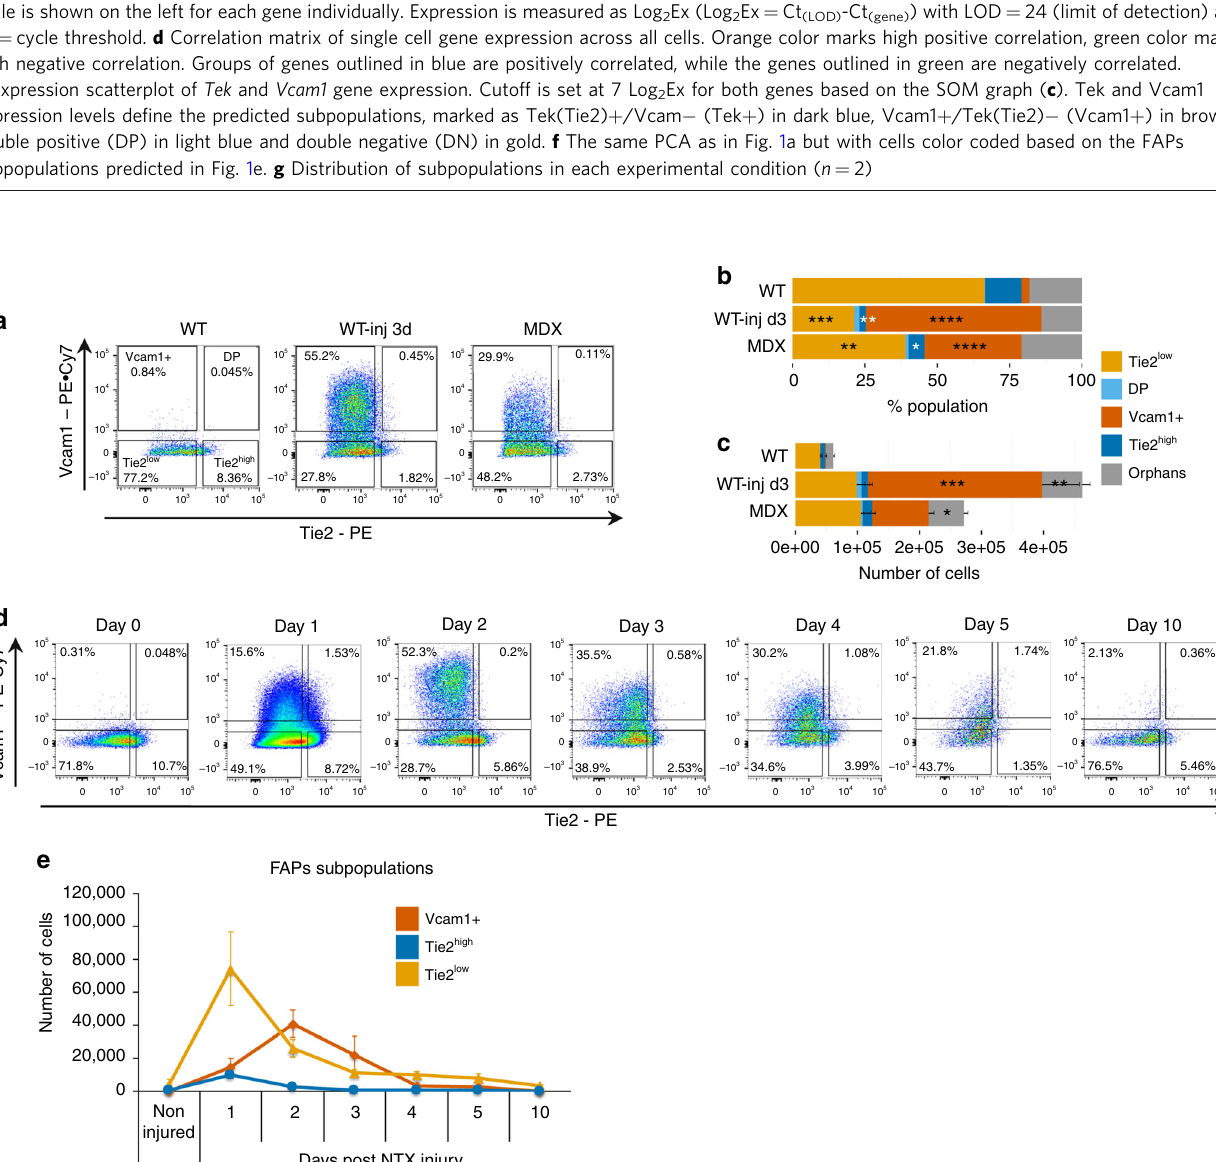
Fig. 2 Vcam1 + and Tie2-expressing cells are dynamic subpopulations of FAPs. a Representative FACS plots of FAPs isolated from hindlimb muscles and analyzed based on Tie2 and Vcam1 expression in wild type (WT), WT notexin-injured day 3 (WT-inj d3) and dystrophic mdx C57Bl/10 mice (MDX). b Distribution of subpopulations in each experimental condition by FACS analysis (mean + s.e.m., n = 4, * p -value P < 0.05; ** P < 0.01, *** P < 0.001, **** P < 0.0001). Statistical signi fi cance was determined by one-way ANOVA with Bonferroni post hoc test, and comparisons to the WT control group are reported. c Number of cells in each FAPs subpopulation for each experimental condition by FACS analysis ( n = 4, mean + s.e.m., one-way ANOVA, * P < 0.05, ** P < 0.01, *** P < 0.001). d Representative FACS plots of FAPs based on the expression of cell surface markers Tie2 and Vcam1 following notexin (NTX) injury in WT mice at indicated time points. FAPs were isolated from tibialis anterior (TA) muscles of C57Bl/6J mice. e Quanti fi cation of cell numbers for the subpopulations of FAPs in TA muscles during the time course in d ( n = 3 representing independent experiments, mean + We noted that the proportionally higher abundance of Tie2 high resembled the pattern of subFAP distribution predicted by single cells in unperturbed (WT) muscles, as compared to the other cell gene expression pro fi ling of FAPs (compare Figs. 1g and 2b), conditions, was only observed in percentage over the whole with subFAPs formerly named as DN in the single cell gene population (Figs. 1g, 2b), but not in absolute amount (Fig. 2c). In expression analysis, now being renamed as Tie2 low , to indicate this case, given the great disparity in number of cells in the total that they represent cells within a low range of Tie2 expression.